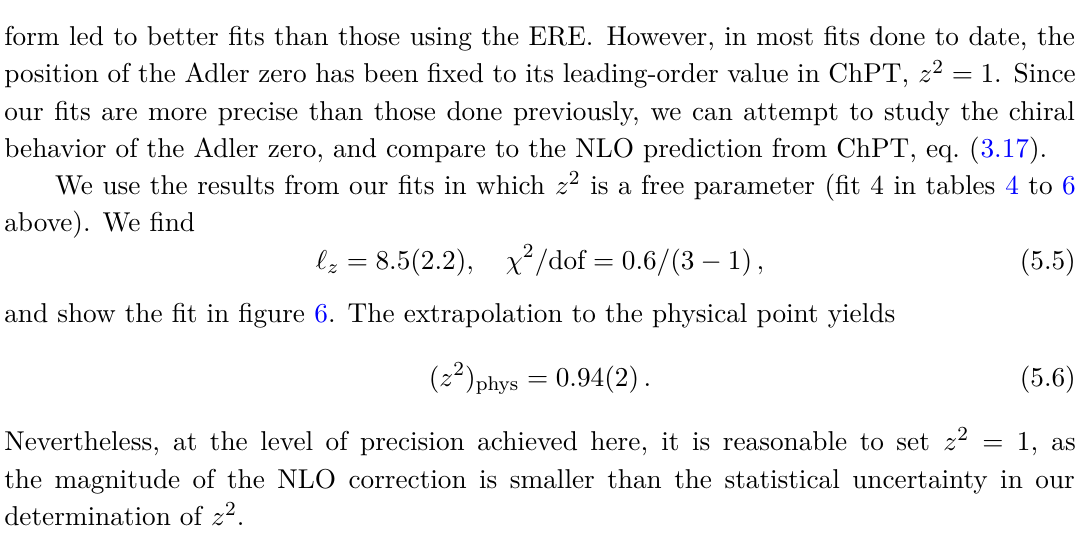
Figure 6. NLO chiral fit to the position of the Adler zero. Notation as in figure